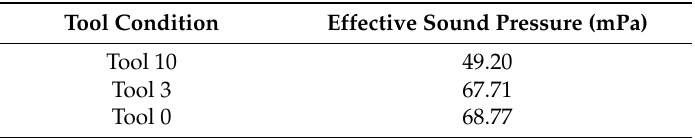
Figure 10. Acoustic and surface measurement for Tool 0 during milling: ( a ) image of tool with wear condition; ( b ) noise emission during load (Feed = 3 in/min; depth of cut = 0.05 in and RPM = 750); ( c ) milled piece; and ( d ) image on surface roughness. Table 4. Effective sound pressure for three different milling tool condition.